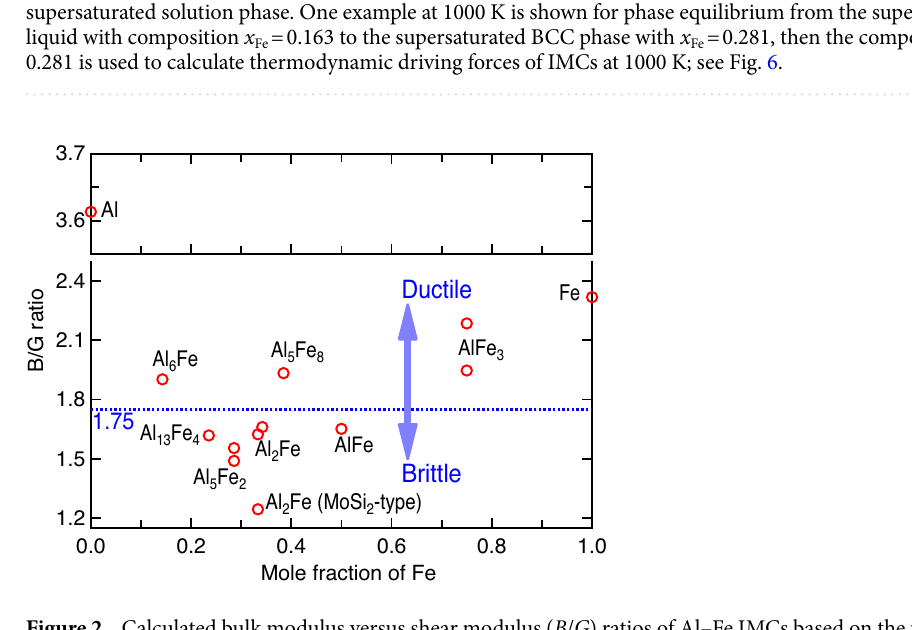
Figure 2. Calculated bulk modulus versus shear modulus ( B / G ) ratios of Al–Fe IMCs based on the present DFT calculations; see details in Table S3. Note that Pugh’s criterion 11 of 1.75 is a rough value to separate the ductile and brittle materials, as discussed in the authors’ responses to Reviewers in Ref.